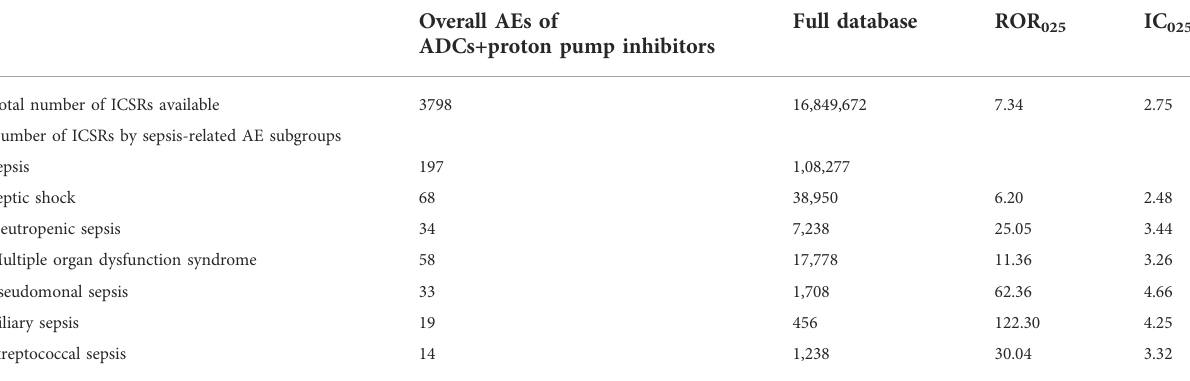
TABLE 6 Sepsis safety signals for ADCs and proton pump inhibitors combination